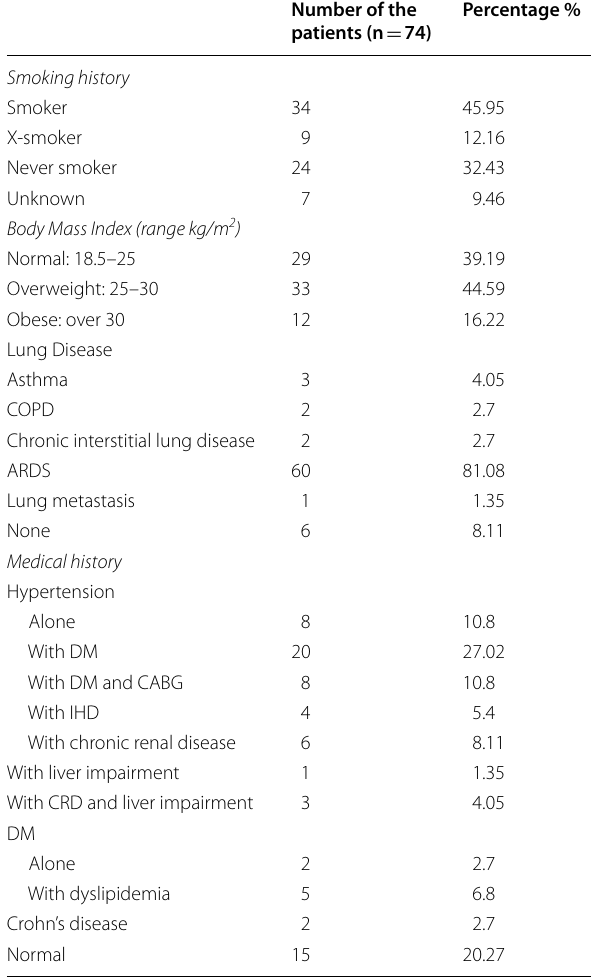
Table 1 Clinical characteristics of the studied patients